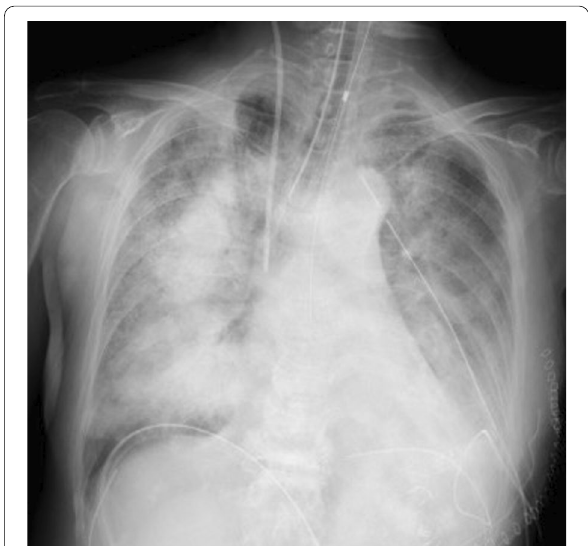
Fig. 4 Re-expansion pulmonary edema. Postoperative chest radiograph showed re-expansion pulmonary